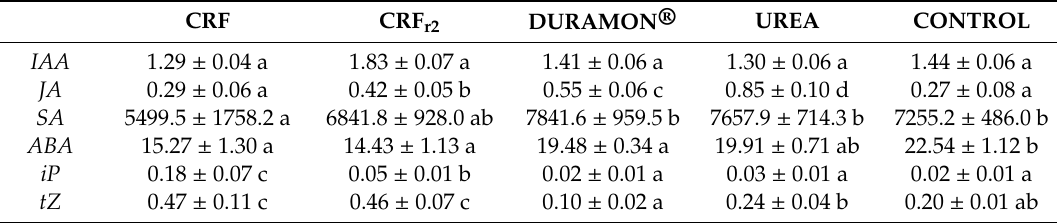
Di ff erent letters in the same row indicate significant statistical di ff erences (Tukey’s test, p <